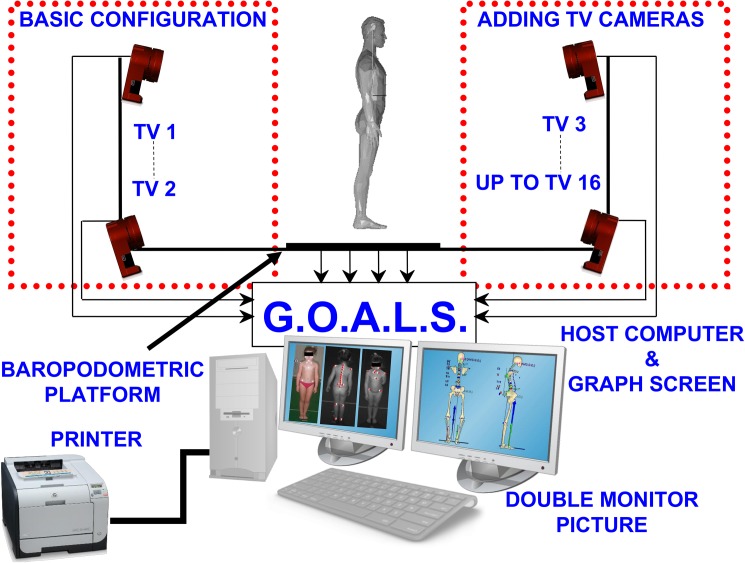
The experimental set-up used for 3D posture analysis: GOALS system and baropodometric platform configuration.